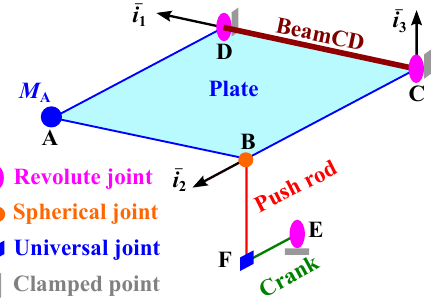
Figure 5. Configuration of the crank-plate mechanism.